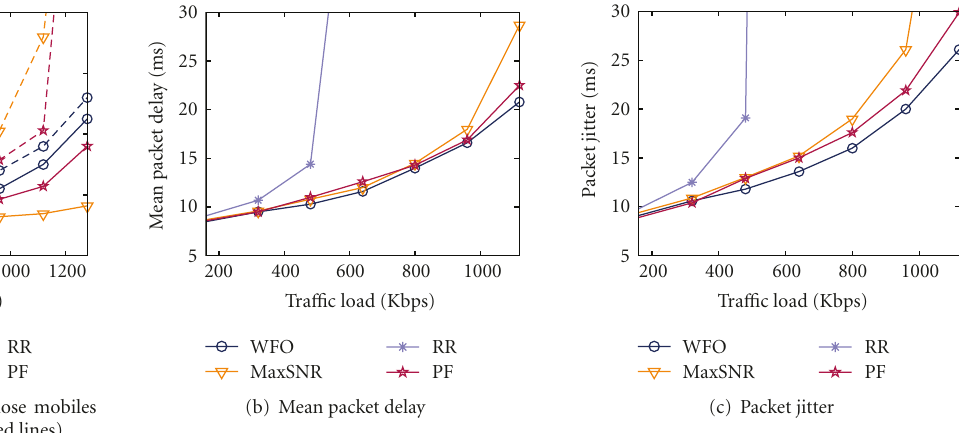
Figure 8: Bu ff er occupancy, delay and